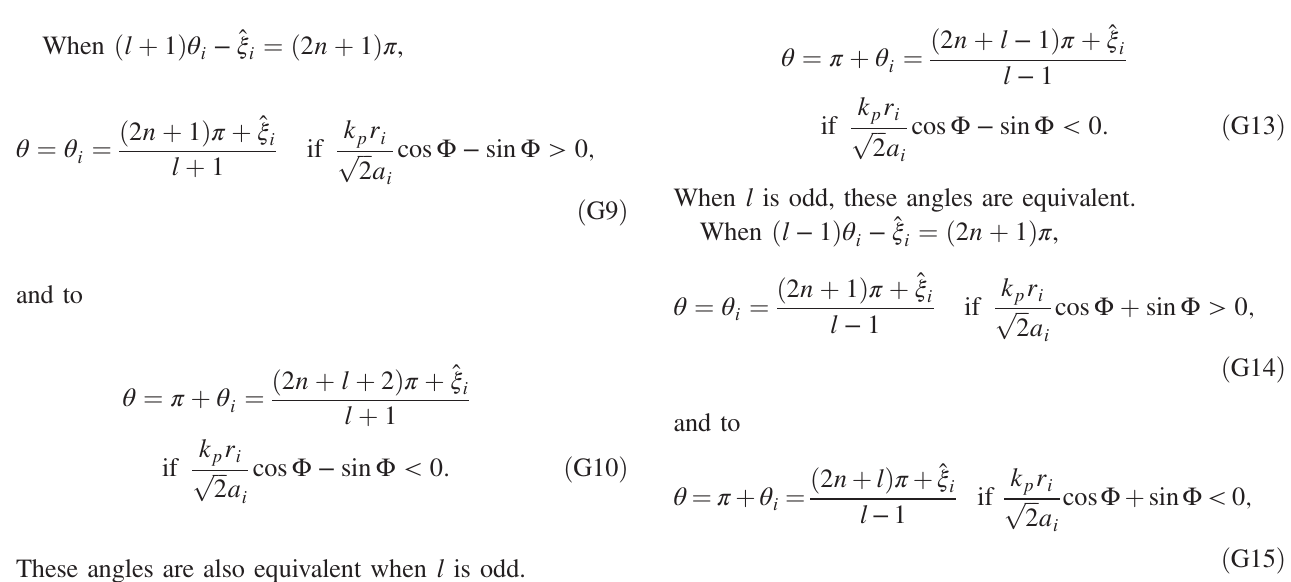
ð ¯ x Þ . Note the value at each α is normalized by 10 when 1 ≤ j α j < l and its maximum for other α . FIG. 8. The value of g l; σ